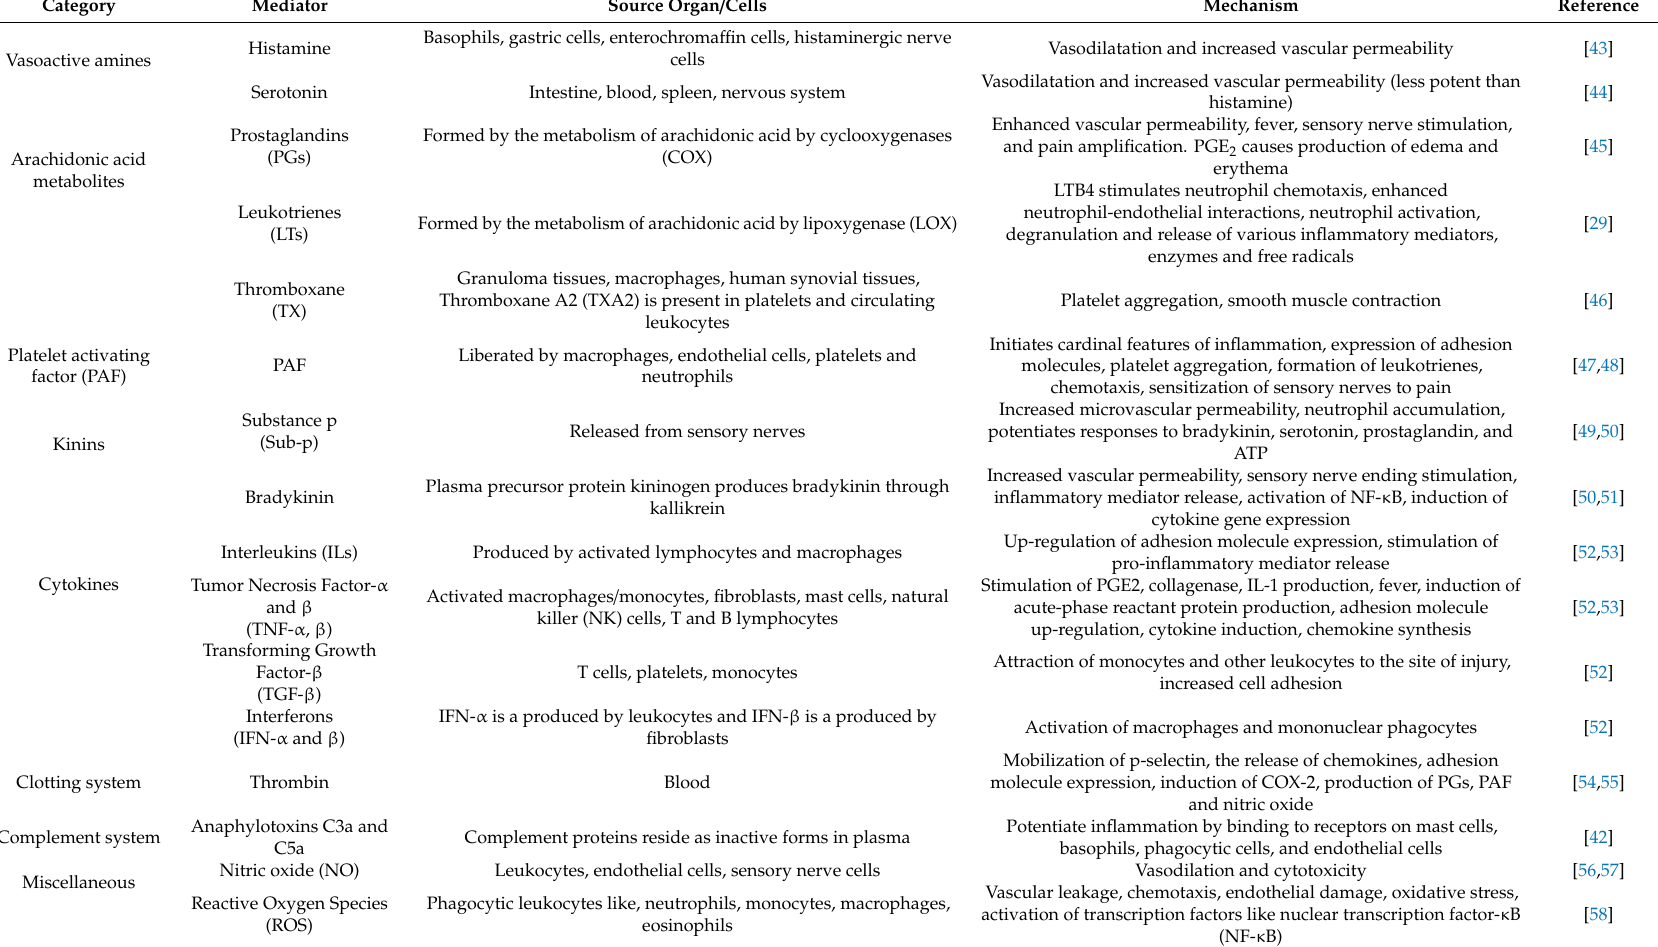
Table 1. Di ff erent mediators of inflammation and their pathophysiological